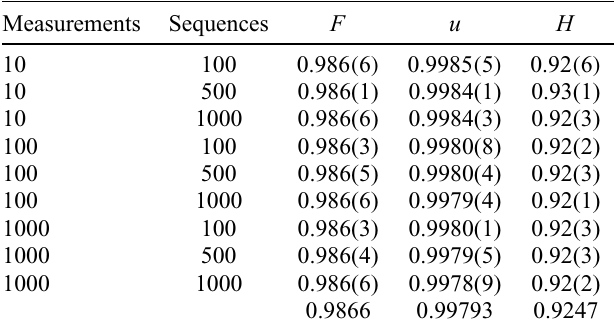
TABLE II. Numerically estimated values of the fidelity, uni- tarity, and self-adjointness from the single-qubit 2-RB with the finite numbers of measurements and samplings of unitary sequences. We set p = q = 0.02. The theoretical values are listed at the bottom of the table.